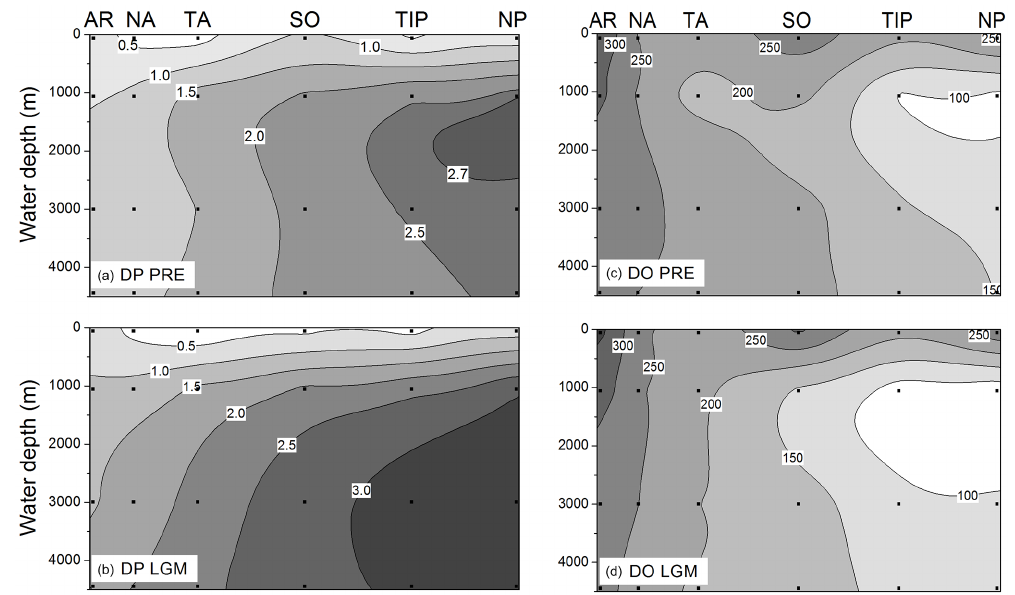
Figure 8. Concentrations (in µM) of dissolved phosphorus (DP) and oxygen (DO) in the pre-anthropogenic modern ocean (PRE, model results for 0ka, a : DP, c : DO) and during the LGM (model results for 21ka, b : DP, d : DO, Table C4). The contour plots shown here and in Figs. 9 and 11 are based on concentrations calculated in simulation STD for each of the 24 ocean boxes (indicated as grid